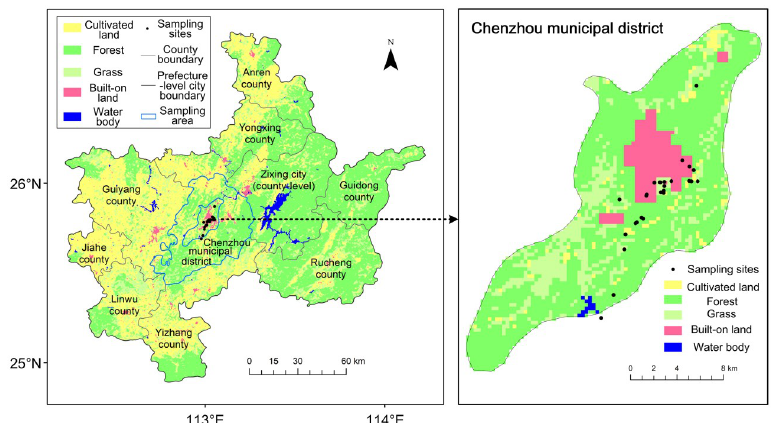
Fig 1. Land uses of the study area of Chenzhou City (prefecture-level) in 2015, and the sampling sites locations used for rodent surveillance. Different colors in the base map represent the different types of land use (yellow: cultivated land; green: forest; light green: grass; rose: built-on land; dark blue: water body). The dark points and areas within the blue line show the locations of the sampling sites and areas of rodent surveillance, respectively. The gray and dark lines are boundaries at county and prefecture-level city, respectively. The maps for the land use types in Chenzhou City during 2006–2015 can be found in the